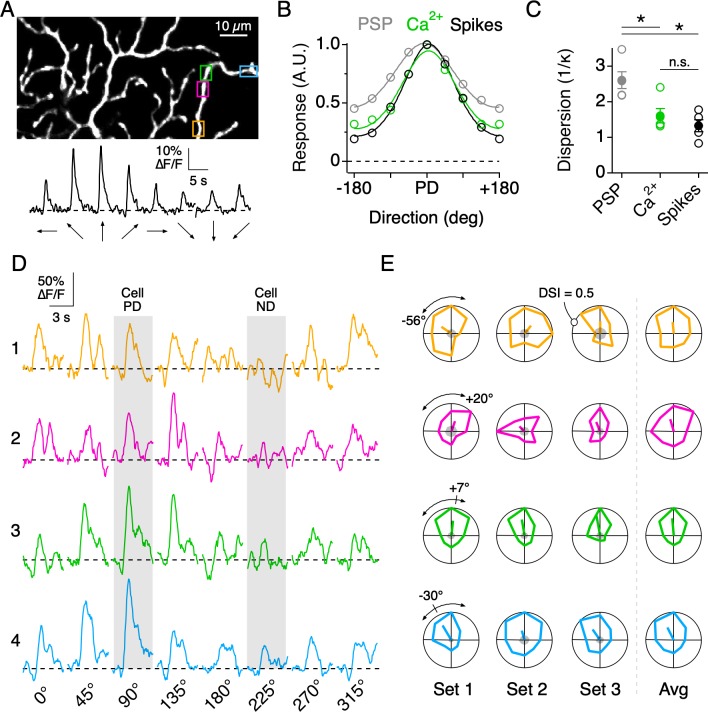
Directional tuning in DSGC dendrites in the absence of NaV activity.(A) Top, Imaging area of the ON arbor of an ON-OFF DSGC. Bottom, Ca2+ signals over the entire imaging window in response to a positive contrast spot moving in eight different directions. (B) The average tuning curves of the spiking response, subthreshold somatic voltage (PSP), and dendritic Ca2+ signals (n = 7 cells). Solid lines indicate Von Mises fits to the data. The PD is normalized to that of the spiking response. (C) The value 1/κ, extracted from the Von Mises fits, is a measure of tuning width, or angular dispersion, for circular data. The tuning curve from the somatic voltage was significantly broader than both the Ca2+ signals and the spiking responses. Asterisks indicate p<0.05, t test. (D) Ca2+ signals over a single stimulus set (one set = 8 directions) at four nearby ROIs on the same dendritic branch, as demarcated by the colored boxes in A. The PD and ND, determined using the extracellular spiking response, are indicated by the shading. (E) Polar plots of the peak Ca2+ responses over consecutive stimulus sets, with the PD of each dendritic ROI indicated by the line extending from the origin, the length of which denoting the DSI, a measure of tuning strength (see Materials and methods). The arcs above the polar plot indicate the range in the preferred angle across these four sites on a single stimulus set. Right, the average polar plot for each ROI over the displayed stimulus sets.Figure 4—source data 1.Calcium responses and tuning curves.